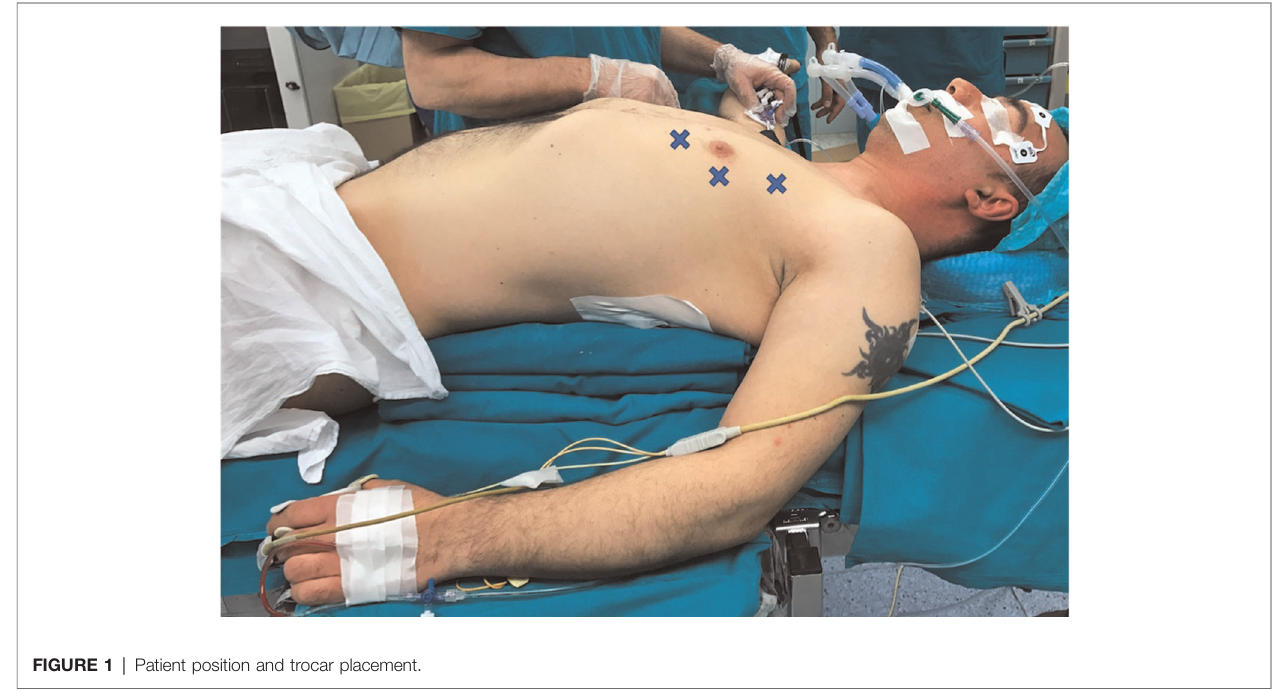
FIGURE 1 | Patient position and trocar placement.